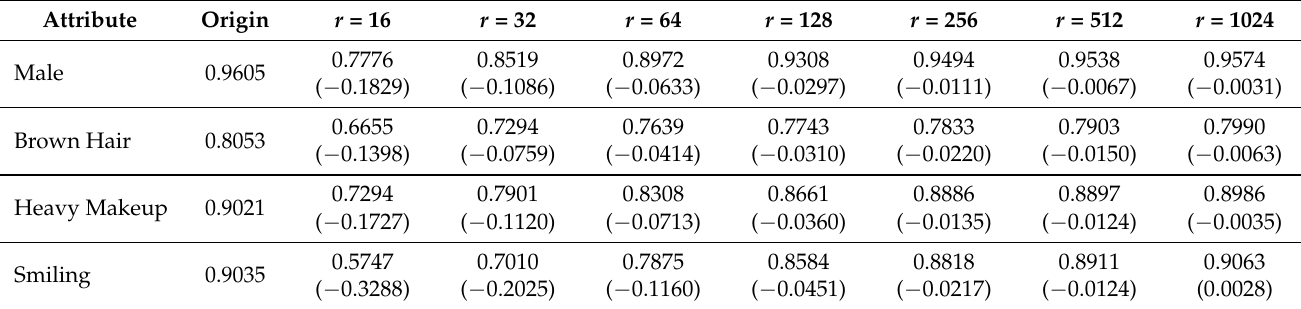
Table 2. Face Attribute Classification